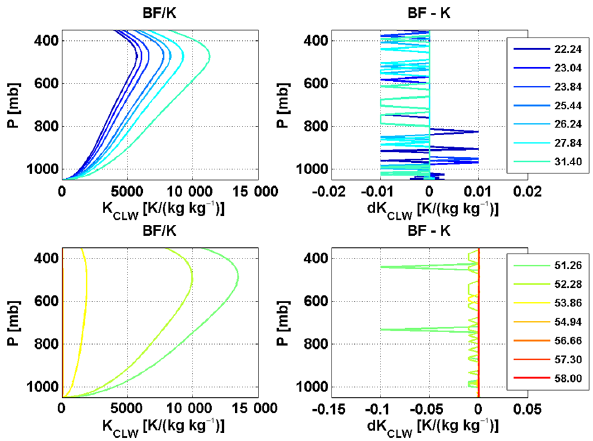
Figure 8. Cloud liquid water Jacobians calculated with the RTTOV- gb BF method and K-module (left) and Jacobian differences be- tween BF and K (right), for K-band (top) and V-band (bottom) chan- nels, respectively. Note that the BF method (solid) and K-module (dashed) are not distinguishable as they nearly completely